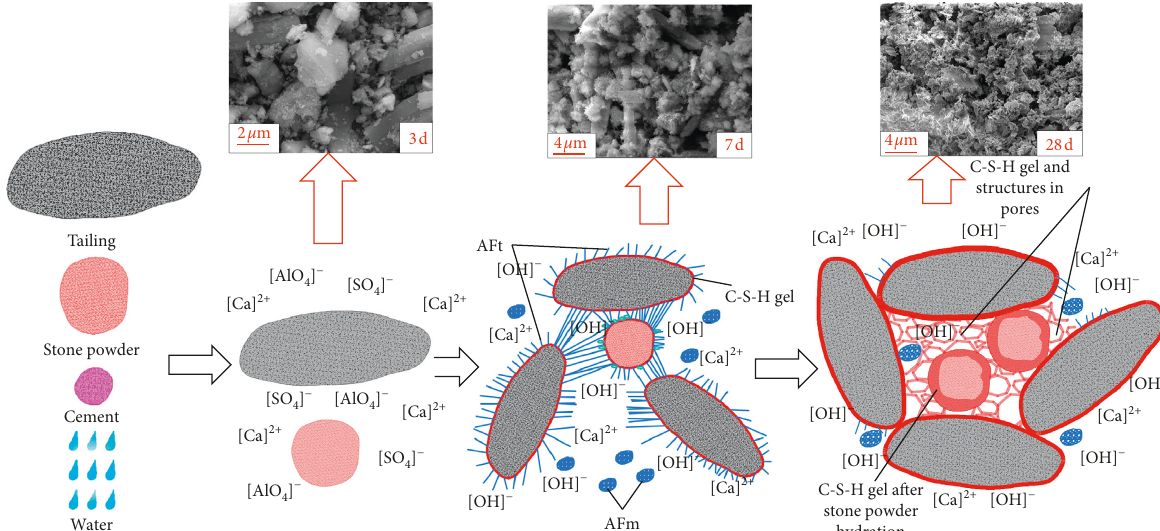
Figure 15: Model for the SPCTB hydration process.